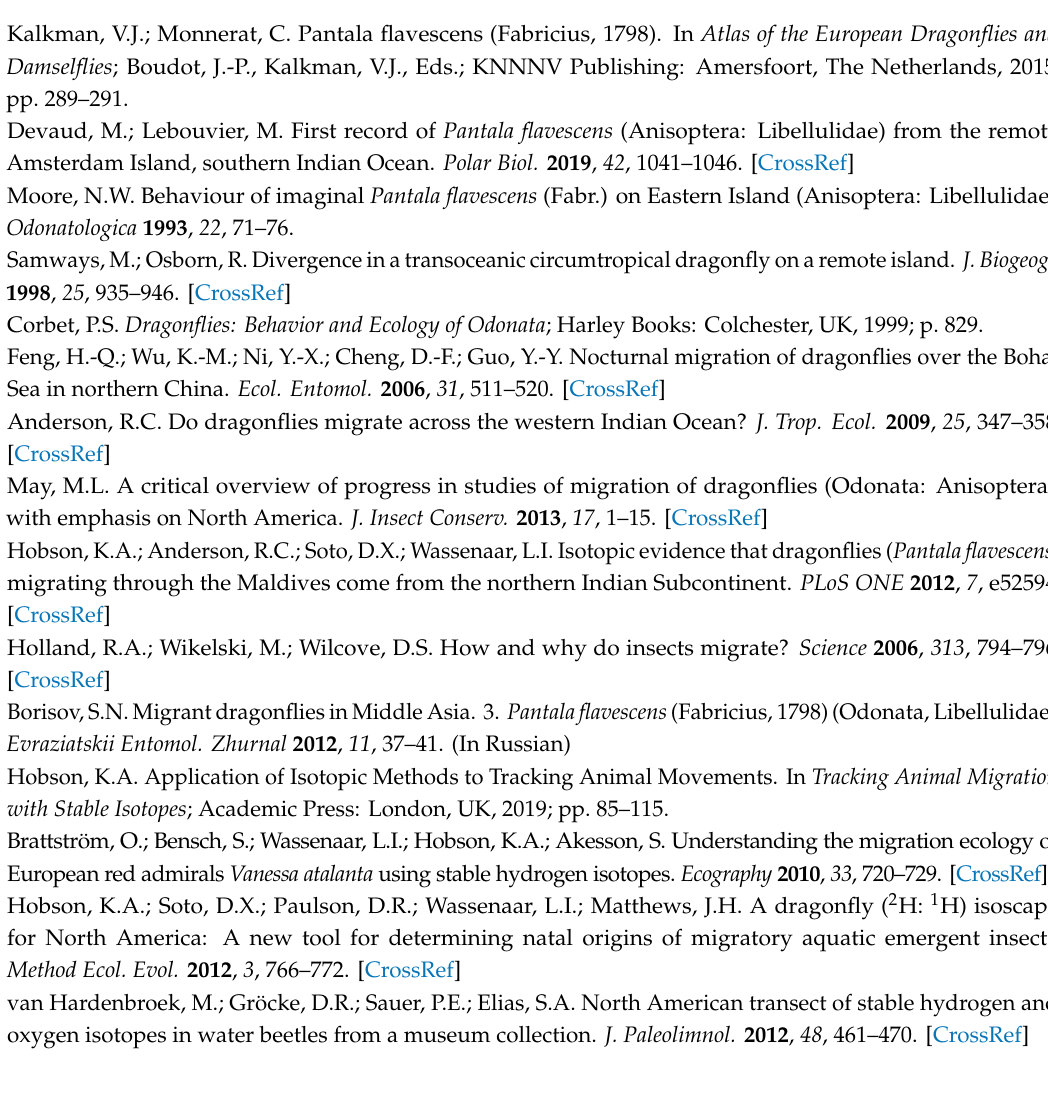
Table S1: Hydrogen isotope composition ( δ 2 H values) of wings and exuviae of Pantala flavescens in Middle Asia, Figure S1: Mean wind vectors at 850 mb in Afro-Asian region during proposed migrations of Pantala flavescens (a) to the north in early spring (February to April) and (b) to the south in autumn (September to November). Images are provided by the NOAA / ESRL Physical Sciences Laboratory, Boulder Colorado, http: // psl.noaa.gov / , data for 1976–2000